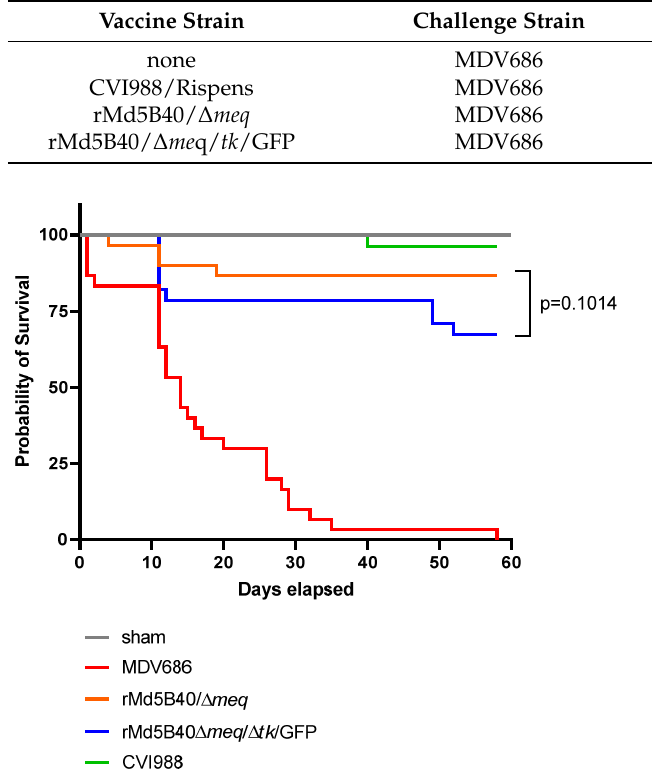
Figure 3. Ablation of the viral tk reduces protection against mortality when challenged by a vv+ MDV. The rMd5B40/ ∆ meq / ∆ tk /GFP (blue line) was not significantly less protective than the parental rMd5B40/ ∆ meq (orange line) in which the tk was intact, although survival trended lower in this construct ( p = 0.1014, Log-rank Mantel-C). As anticipated, the CVI988 vaccine was extremely protec- tive (green line), while unvaccinated animals were highly susceptible to MDV686 in the absence of protection (red